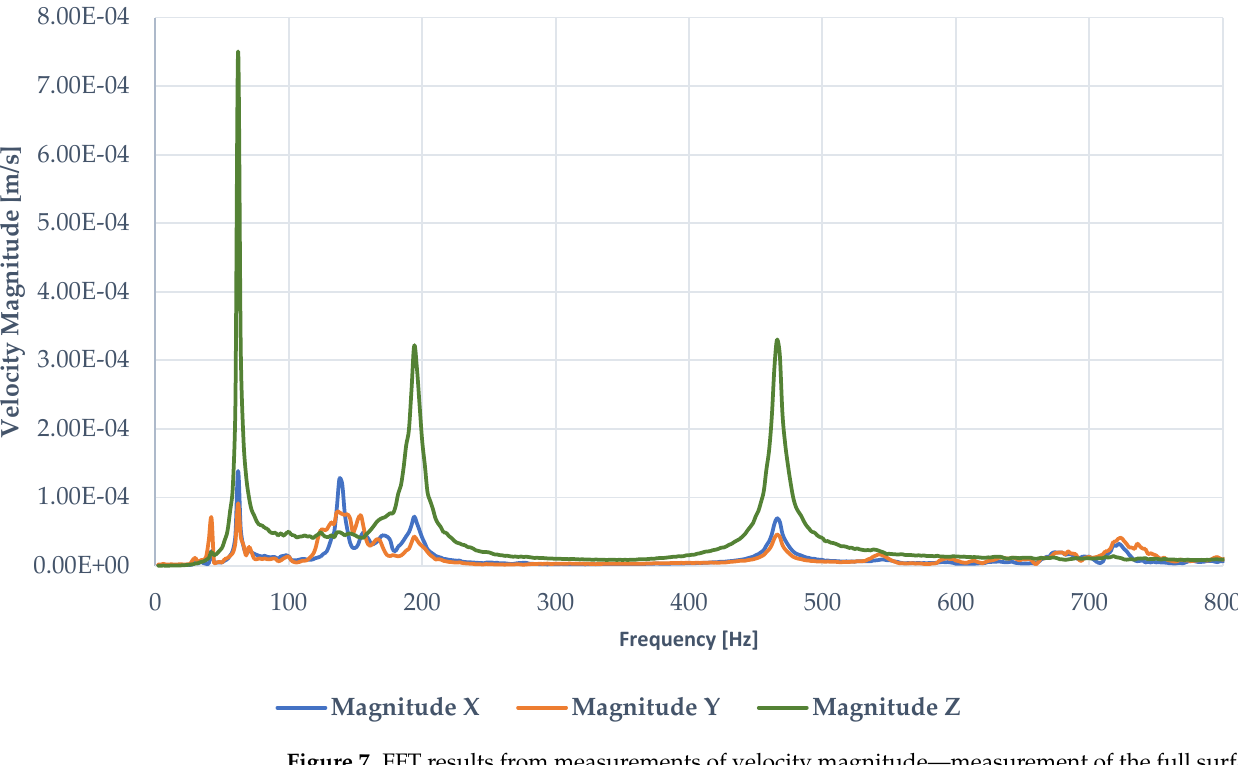
Figure 7. FFT results from measurements of velocity magnitude—measurement of the full surface scan by 3D LDV in the range of 0–800 Hz.